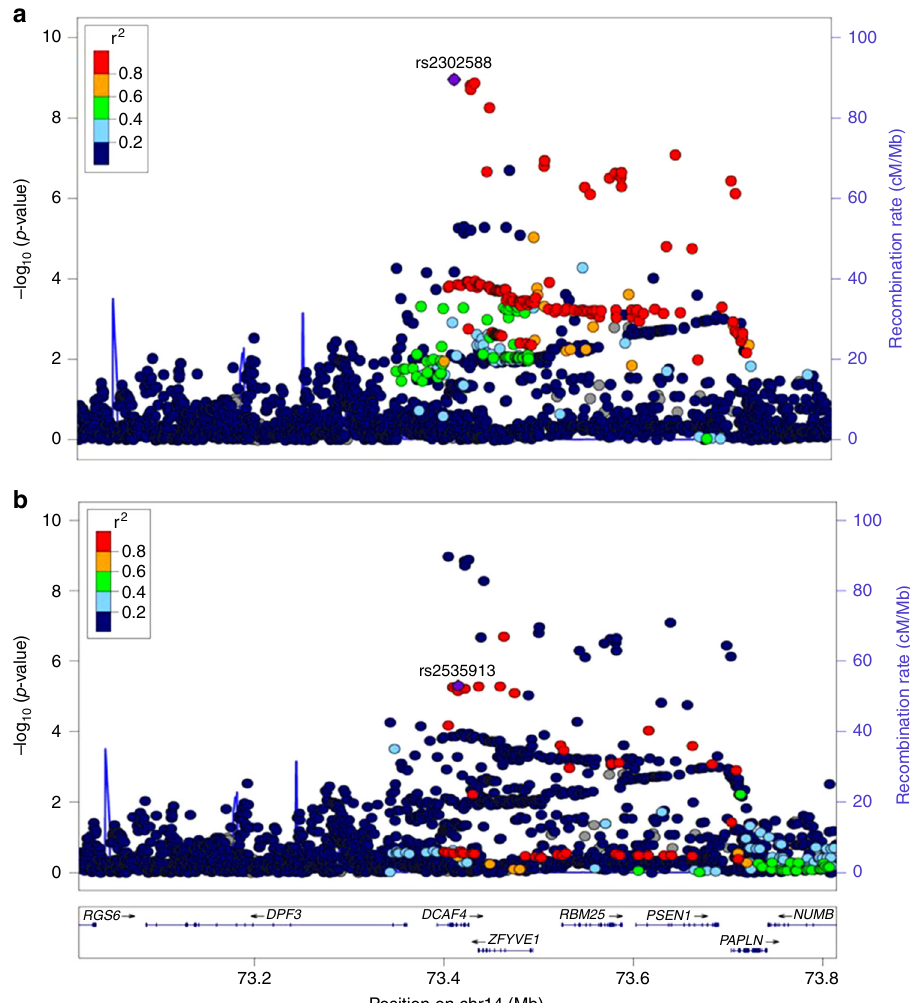
Fig. 4 Regional SNP associations at the DCAF4 gene locus in the trans-ethnic meta-analysis. a Association of lead SNP identi fi ed in the study (rs2302588). b Association of previously identi fi ed index SNP from European GWAS studies (rs2535913). Lead SNP indicated as purple diamonds. LD ( r 2 ) data of SNPs based on ASN panels of 1000Genome database. Plots plotted using LocusZoom